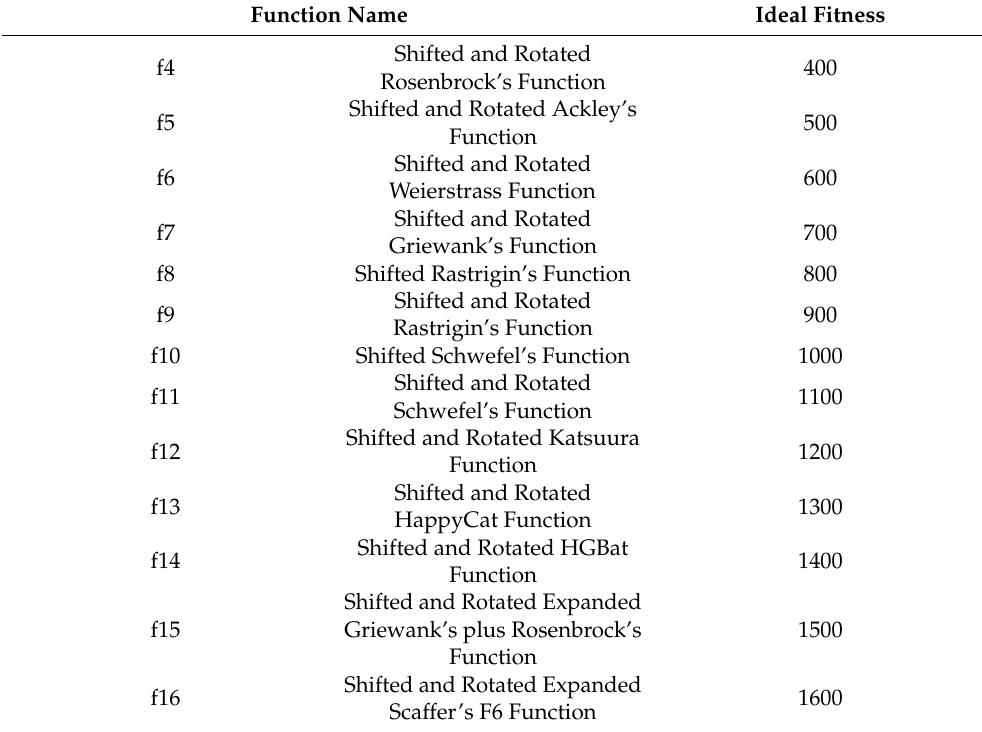
Table 1. List of Benchmark